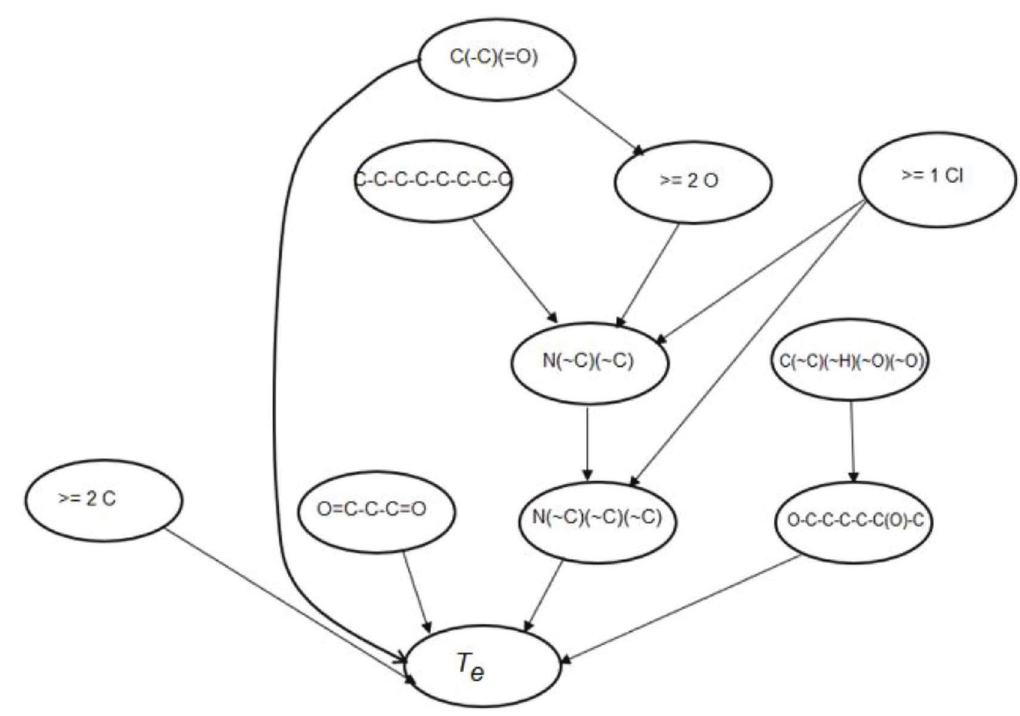
Fig. 4 – Structural causal model (SCM) of the eutectic temperature, T